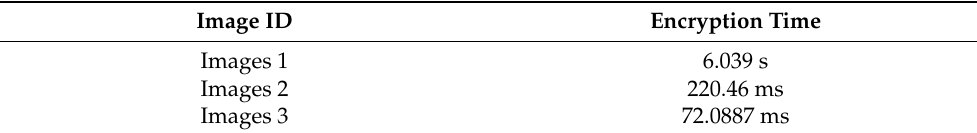
Figure 12. Time analysis on the proposed model. Table 5. Timing Analysis.